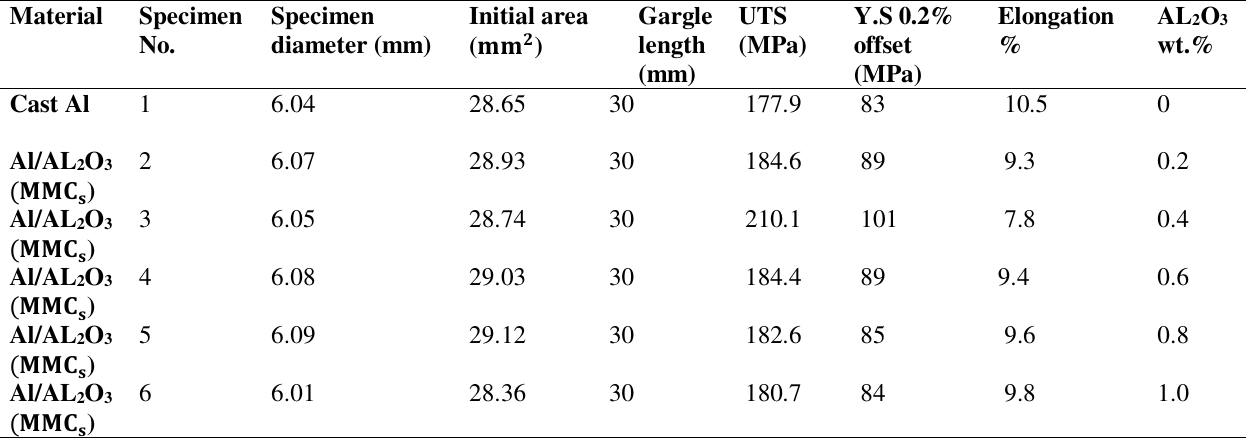
Table 6, Tensile (UTS) and yield (Y.S 0.2% offset) strengths Material